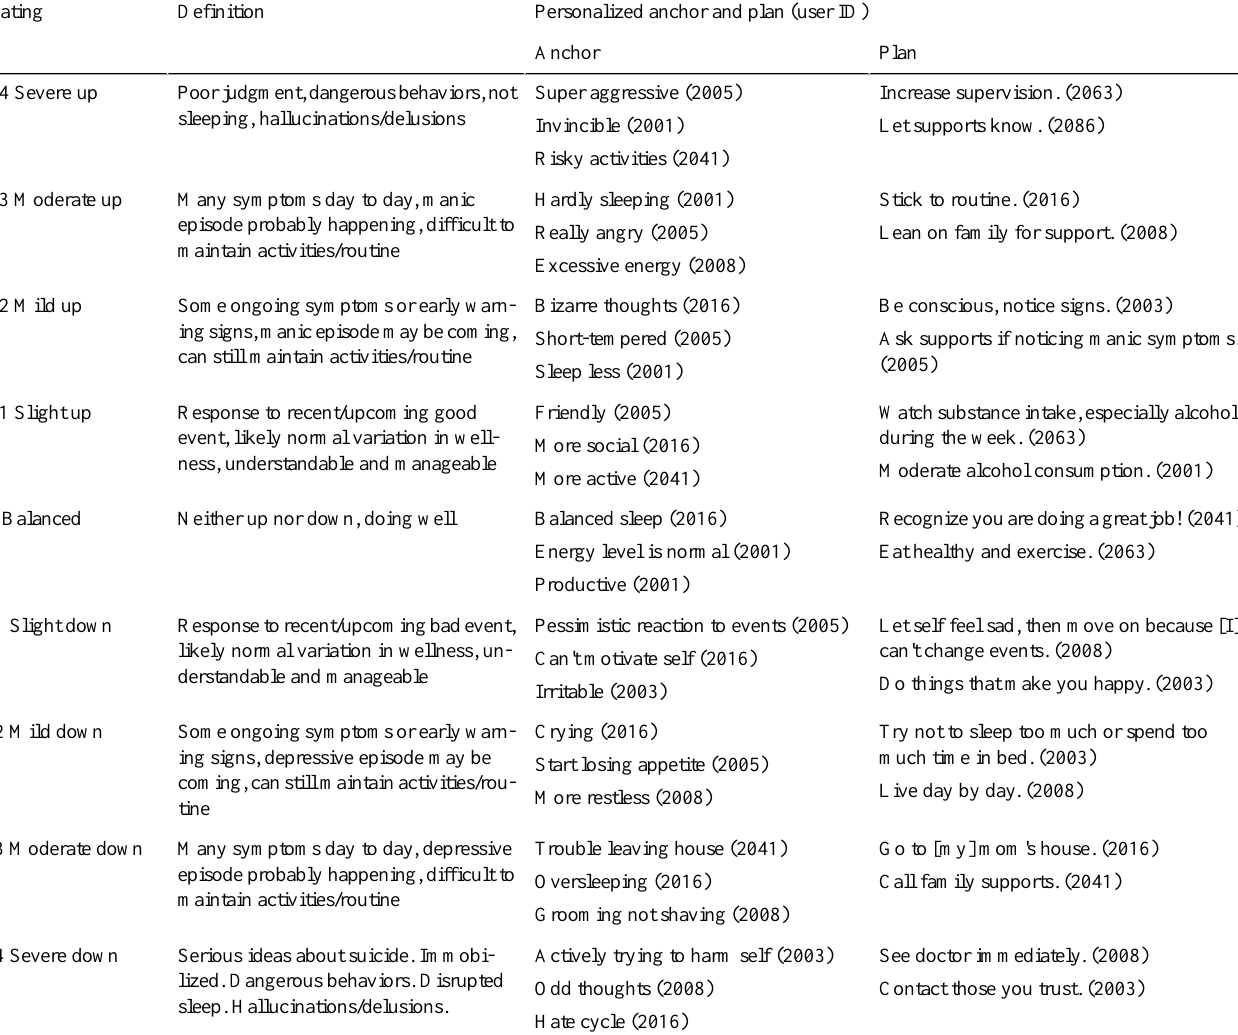
Table 5. Pilot study: coping plan for managing signs and symptoms (n=11).